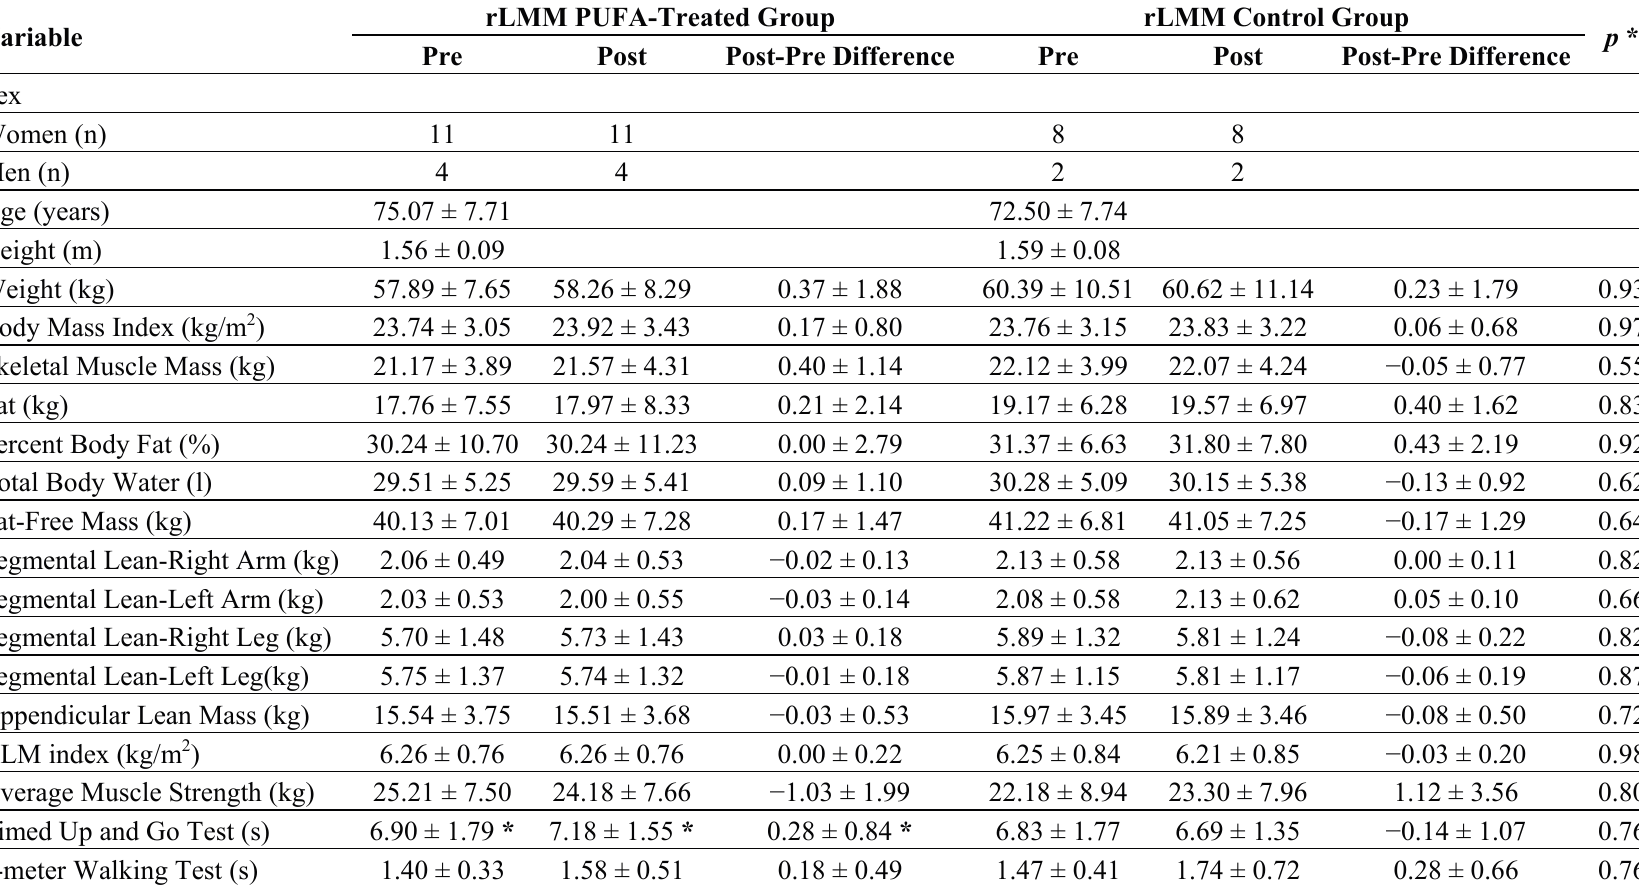
Table 6. Body composition, muscle strength and physical performance before and after 12-week intervention period in subjects with risk of low muscle mass (rLMM)